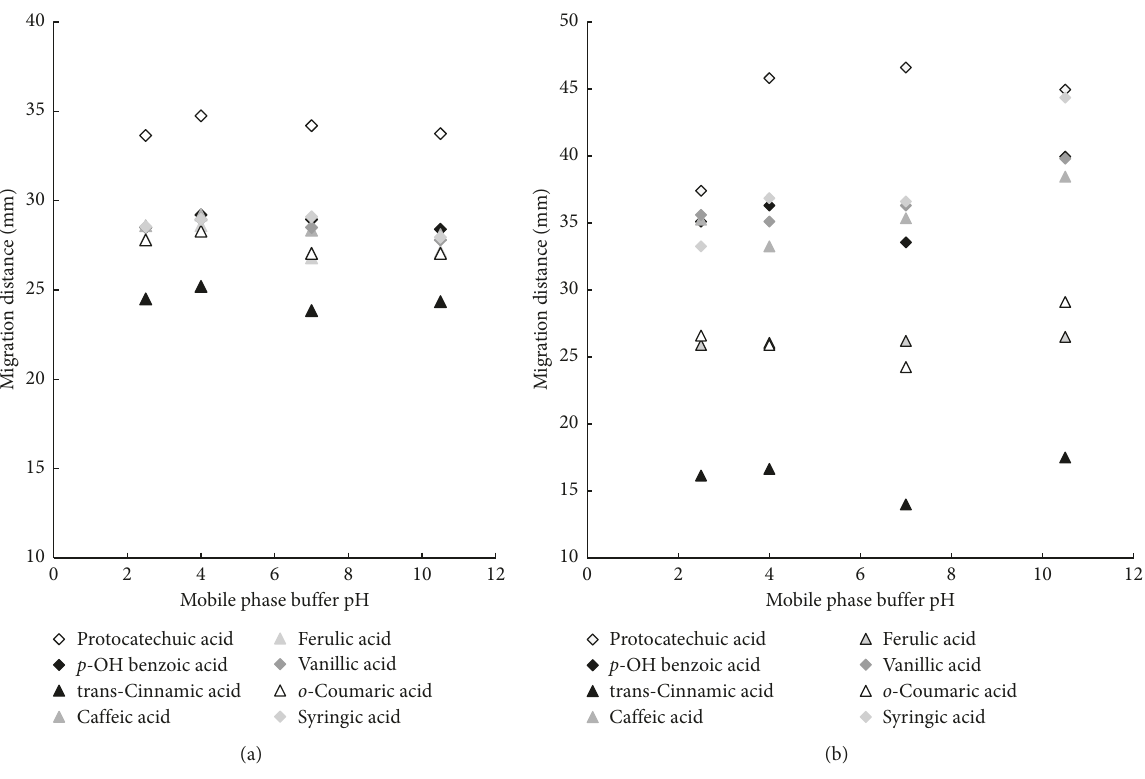
Figure 5: Migration distance of phenolic acids vs. mobile phase buffer pH in the mobile phase for HPTLC (a) and PPEC (b) experiments. The mobile phase: butanol (0.89 M; 8.14% v/v), 10% acetonitrile, 0.1144mM SDS, and aqueous buffer (citric acid, tris(hydroxymethyl) aminomethane, glycine 0.8mM titrated to proper pH with KOH or HCl). The stationary phase: HPTLC RP-18W. TLC: experiment time 20min. PPEC: polarization voltage 800V; experiment time 8 min.